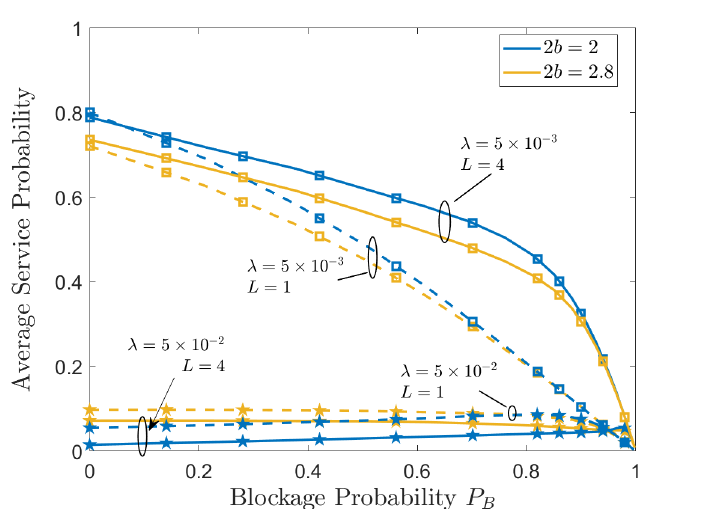
Figure 17. Average service probability vs. the probability or blockage of all the links, for λ = { 5 × 10 − 3 ,5 × 10 − 2 } m − 2 , and number of paths L = { 1,4 } , where L = 1 means that only LOS link exists. Parameters: [ P tx ] dB = 20 dB, NF = 7 dB, BW = 400 MHz, F c = 28 GHz, | β (cid:96) | = path (cid:96) , service area = 100m × 100 m square, AP height h = 10 m, signal-to-noise-and-interference (SINR)